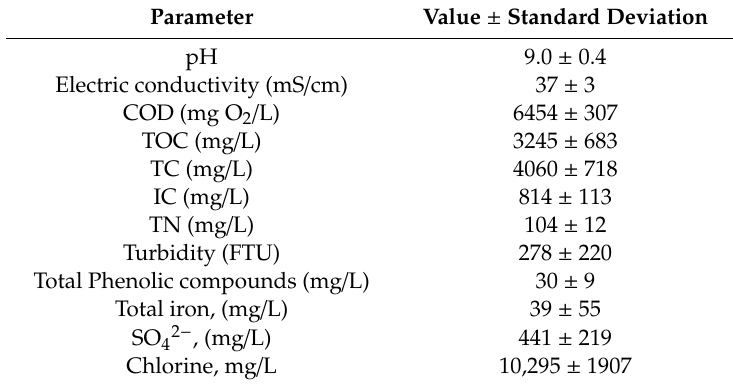
Table 2. Characterization of the representative initial wastewater used in the photocatalyzed